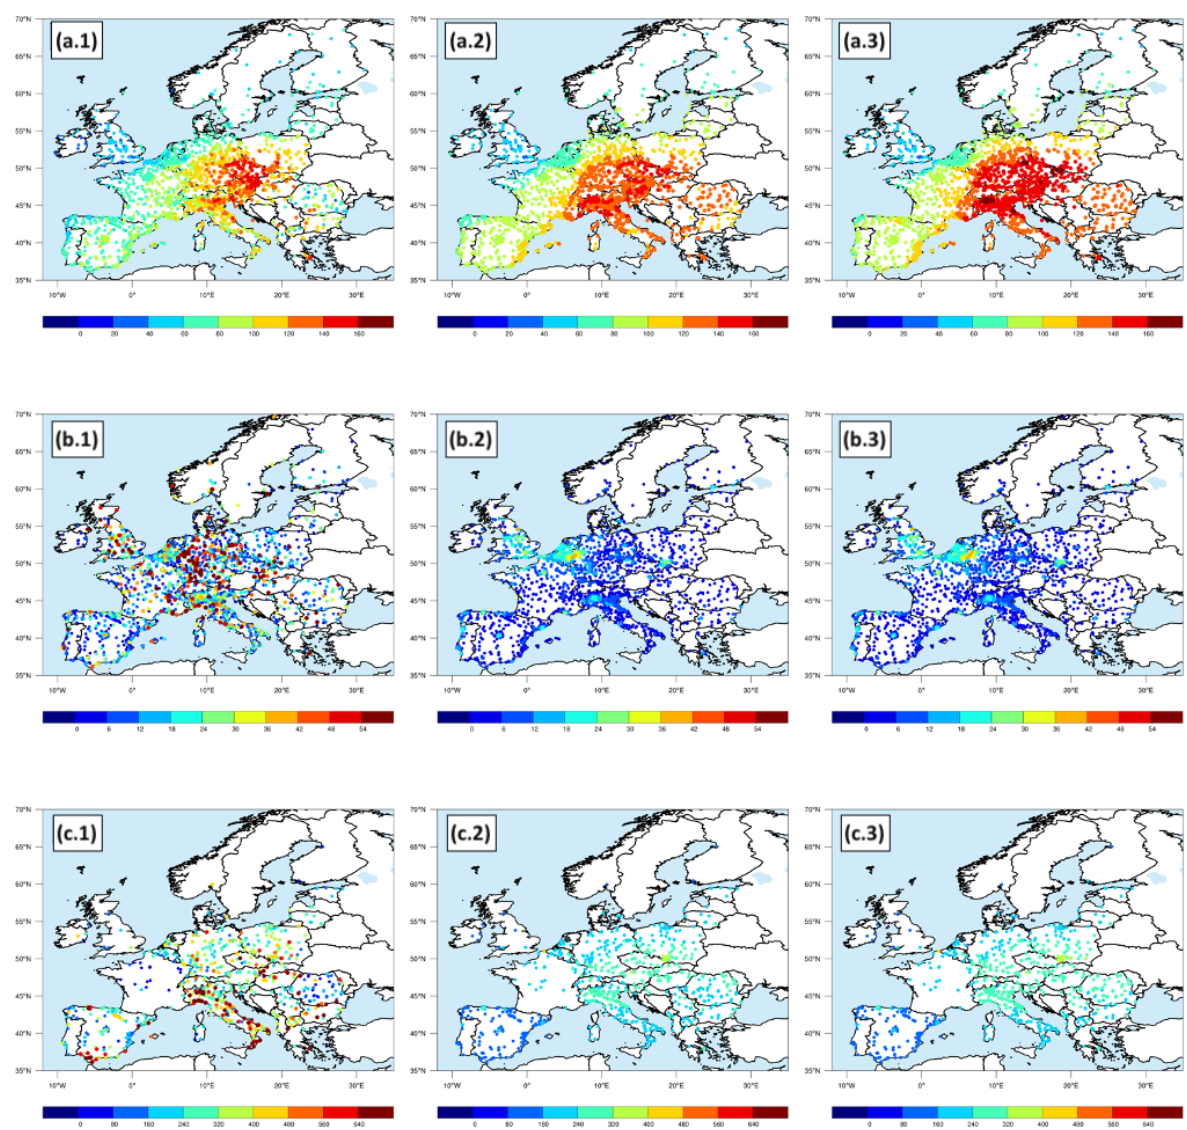
Figure 17. Comparison between the (1) AirBase dataset of the mean daytime (07:00–18:00,UTC), (2) control simulation (M2.04 run), and (3) M2.10 run concentrations with all the MEGAN code updates of (a) O 3 , (b) CO, and (c) NO 2 over the period from 10 August 00:00UTC to 16 August 00:00UTC